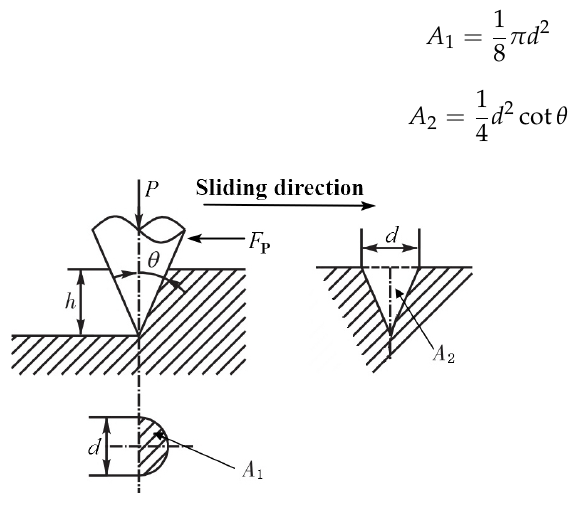
Figure 3. Furrow model of layout of cone rough peak.